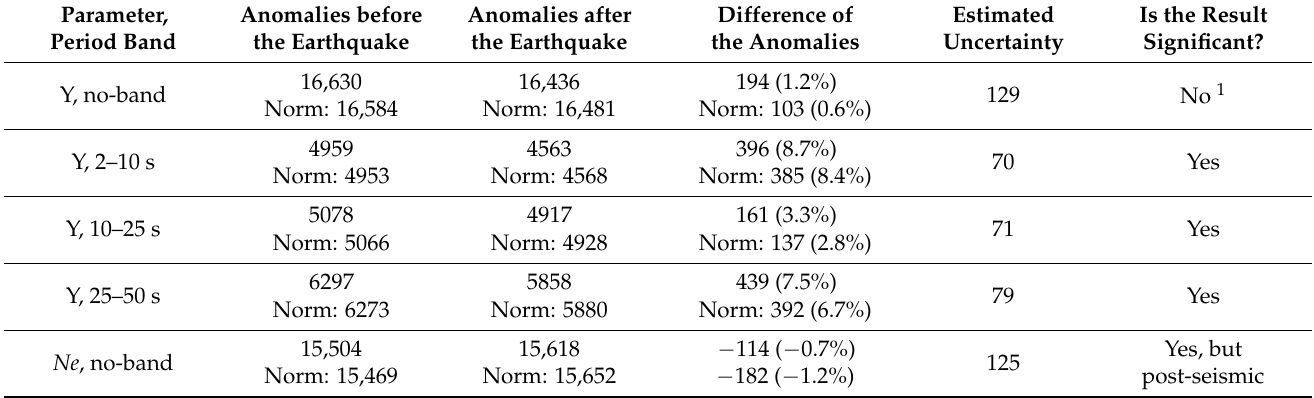
Table 4. Comparison of the number of anomalies in the closer bin to the epicenter before and after the earthquake for the symmetrical investigations (from − 500 days to +500 days) of 8 years of Swarm data correlated with M5.5+ earthquakes by the WSC algorithm. A normalization (“Norm”) is provided to take into account possible different geomagnetic activities occurring before and after each investigated